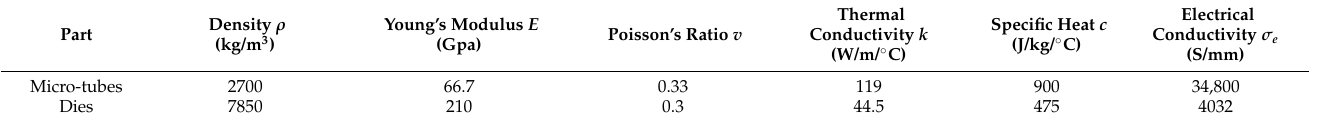
Table 3. The material properties of micro-tubes and